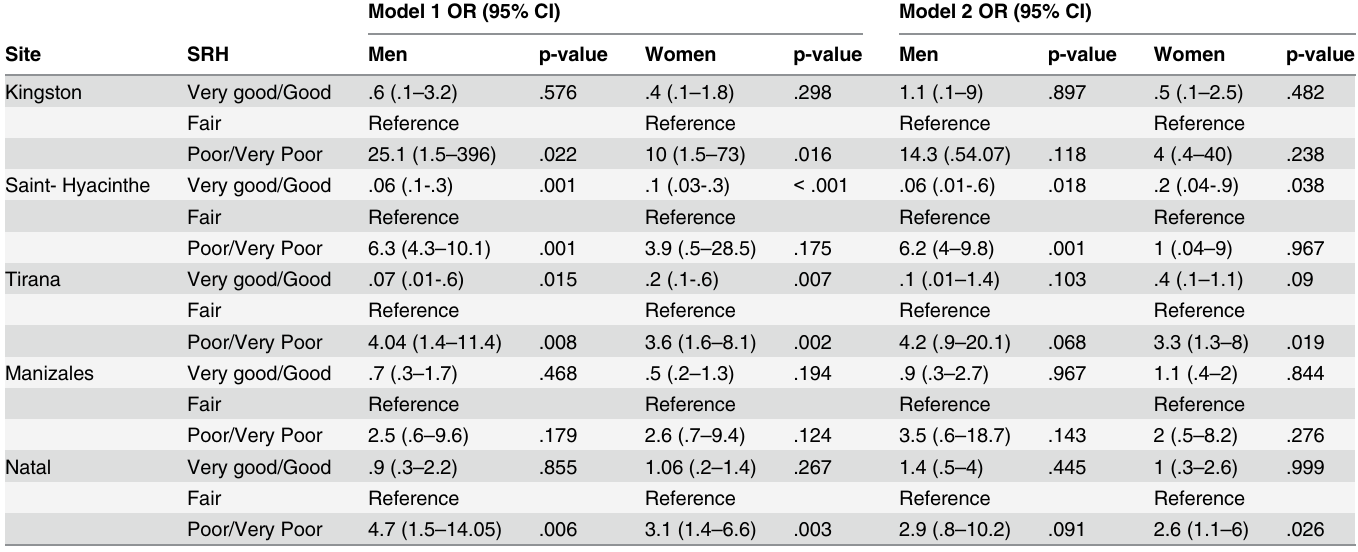
Table 3. Multiple Logistic Regression Models for SPPB as Dependent Variable ( < 8 points) and Self-rated Health in Three Categories (Good/Very Good, Fair [reference], and Poor/Very Poor) as Independent Variable Stratified by